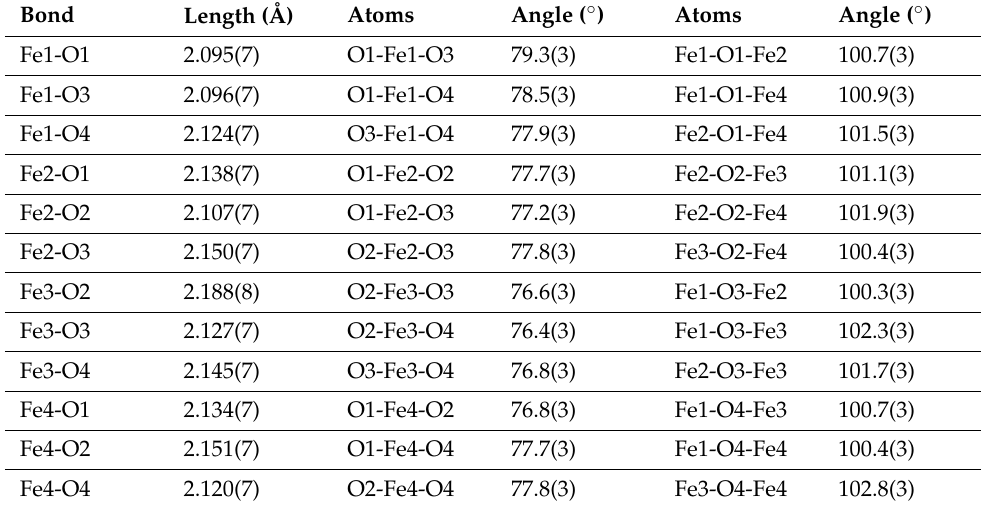
Table 1. Selected bond lengths (Å) and interatomic angles ( ◦ ) for 4